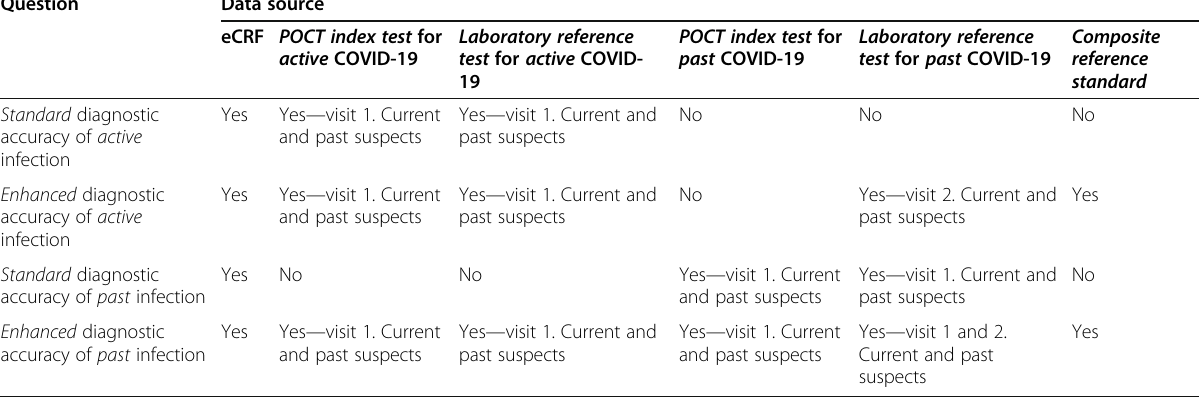
Table 3 Data sources for analysis